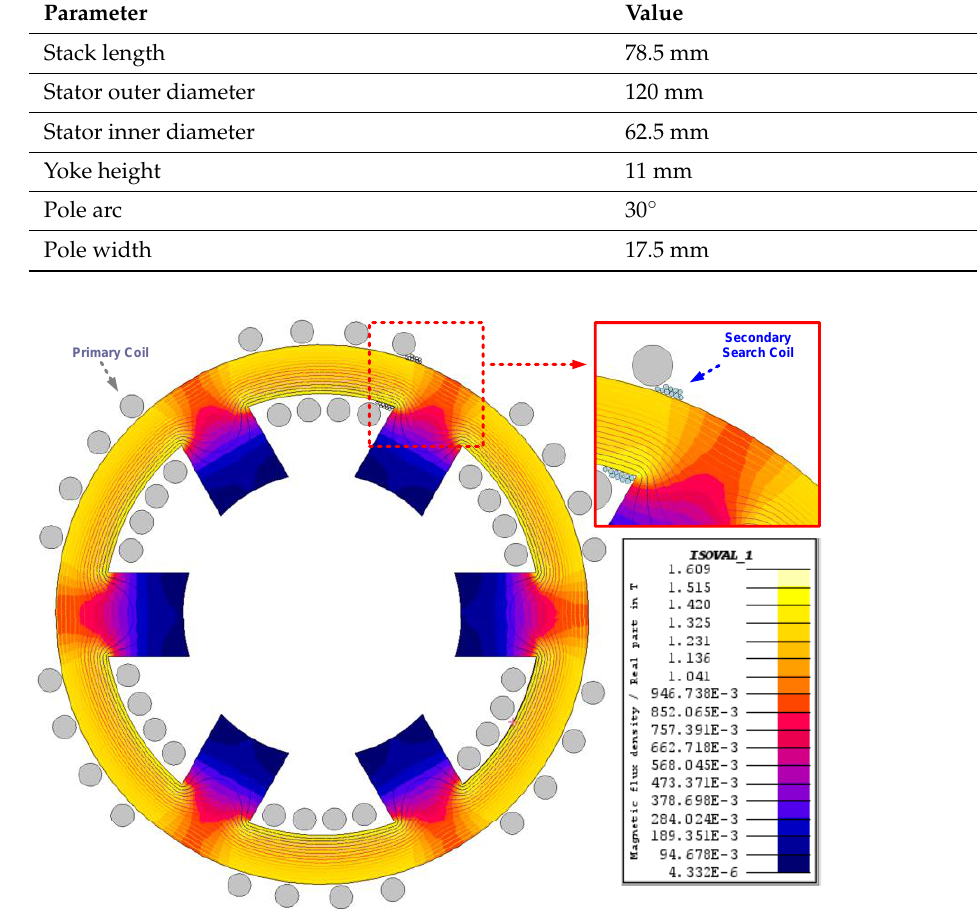
Figure 2. Magnetic flux density of NO20 at saturation level for SRM stator. Table 1. SRM machine stator dimensions.